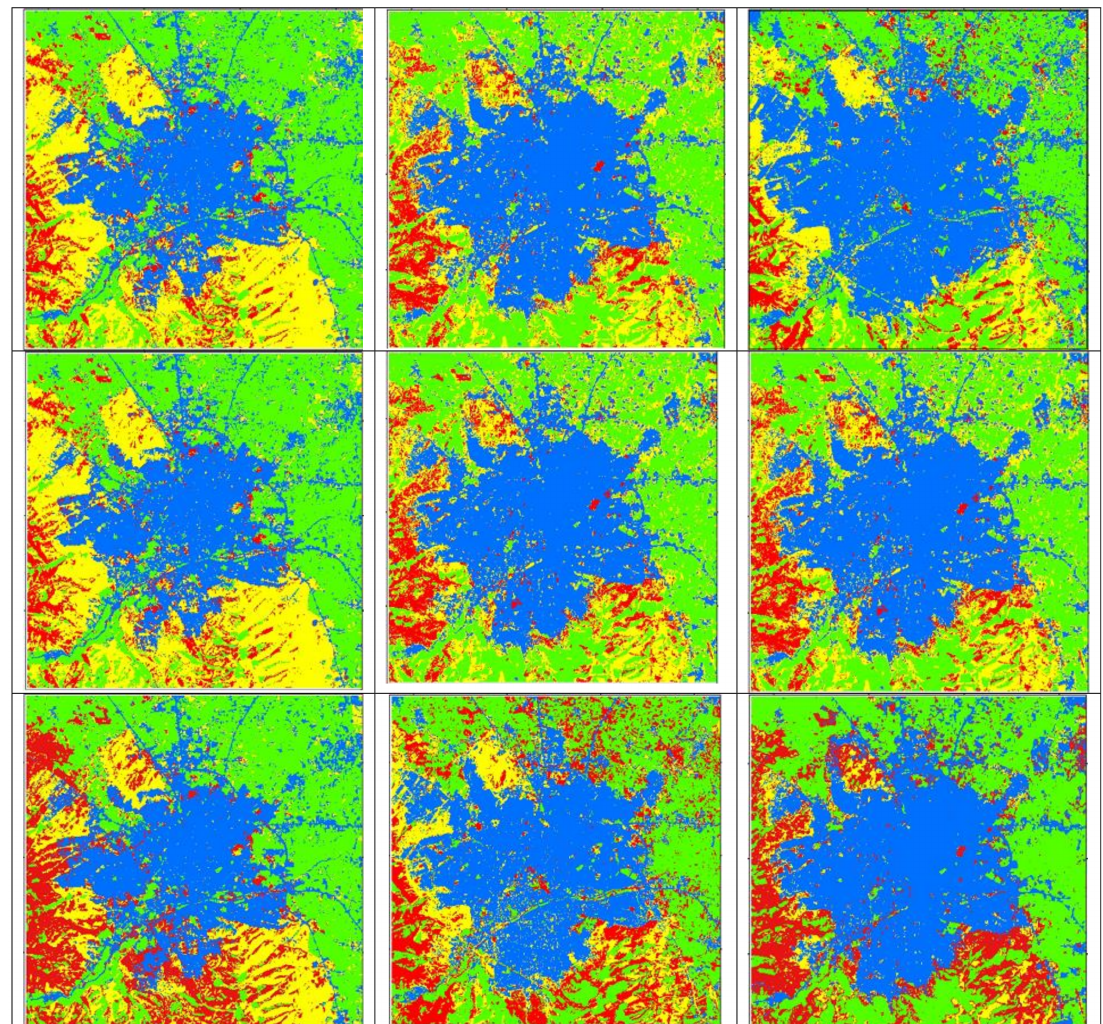
Figure 3. 2000 ( left ), 2010 ( middle ), and 2020 ( right ) land cover maps provided by MLC ( upper ), SAM ( middle ), and SVMs ( lower ). Blue: Built-up, Red: Rocky, Yellow: Soil, Green: